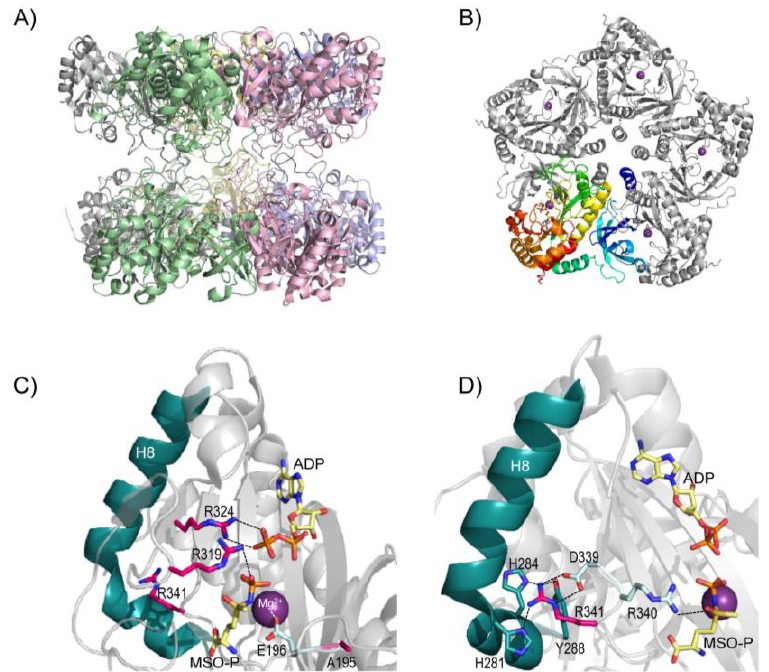
Figure 2. Representation of the crystal structure of human GS (PDB file 2QC8) with the damaging mutations described to-date. ( A ) Human GS decamer showing the two pentameric rings stacking to each other. Each monomer is depicted in a different color. ( B ) Representation of one human GS pentamer with the n1 magnesium ion bound to each monomer (purple spheres). One of the subunits is colored from the N-terminus (blue) to the C-terminus domain (red). ( C , D ) Close-up views of the catalytic site of GS, including bound ADP (in sticks), magnesium (purple sphere), and methionine sulfoximine phosphate (MSO-P) (replacing the glutamate). Oxygen atoms are in red, nitrogen atoms in blue, phosphorus atoms in orange, and sulfur atoms in dark yellow. Residues harboring mutations described here are represented as pink sticks. Other highlighted residues are represented as cyan or light blue sticks. Dotted lines represent salt bridges or atom interactions. This figure was adapted from [61,63].